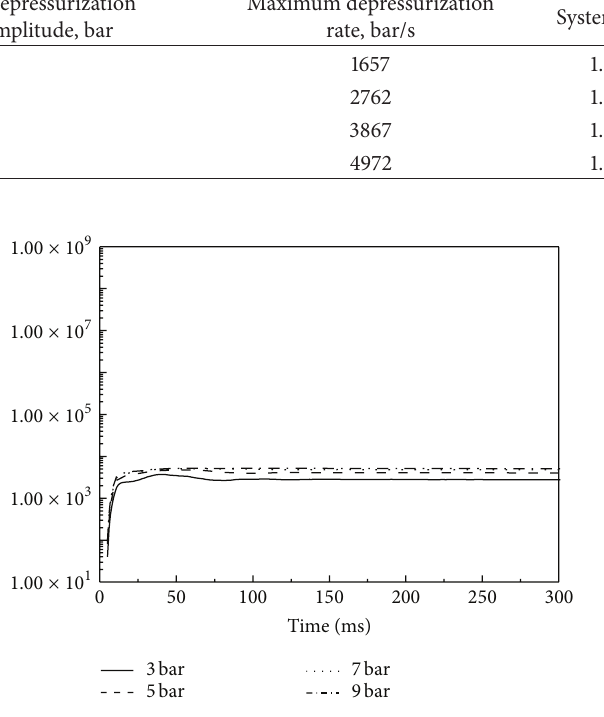
Figure 7: Mass flow rates at the breathing clearance.